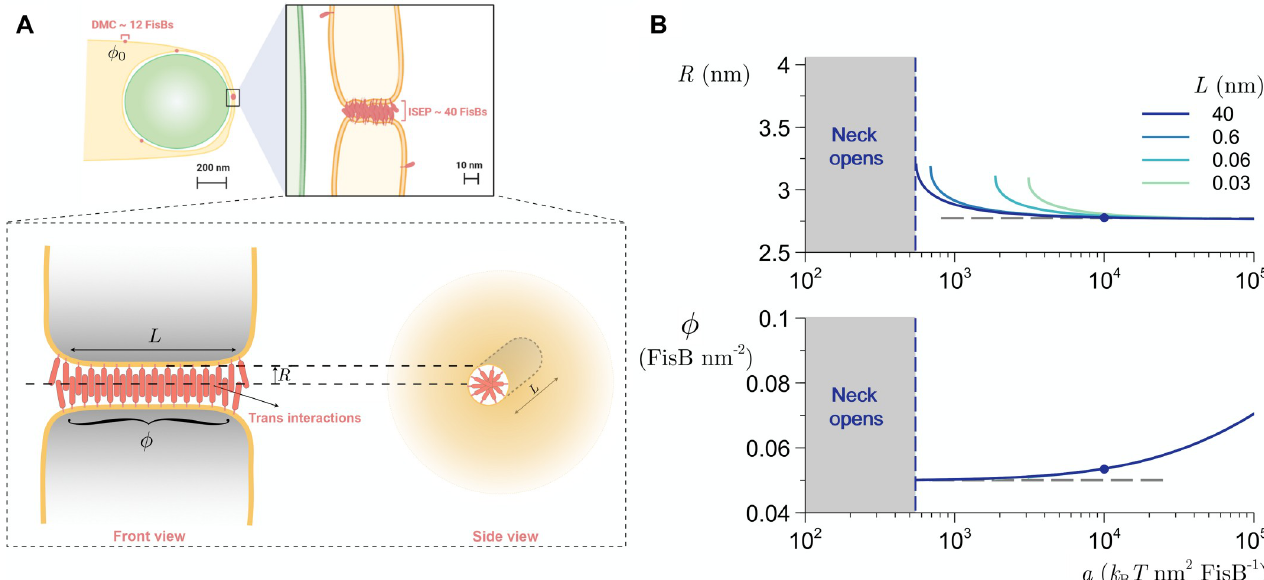
Fig 9. Modeling supports recruitment of FisB to membrane neck via oligomerization without curvature sensing. (A) Left: schematic of the late stages of engulfment, when a small membrane neck connects the engulfment membrane to the rest of the mother cell membrane. Right: schematic of FisB accumulation at the fission site. FisB freely moves around the engulfment membrane and other regions of the mother cell membrane, forming clusters of up to approximately 12 molecules. Cluster motions are independent of lipid microdomains, flotillins, the cell wall synthesis machinery, and voltage or pH gradients. About 40 copies of FisB accumulate at the membrane neck in an immobile cluster. Bottom: modeled axisymmetric membrane neck of radius R and length L connecting two membrane sheets. The uniform areal concentration of FisB in the neck is ϕ . (B) Top: equilibrium radius of the neck as a function of FisB trans homo- oligomerization strength, a , for several values of neck length, L . Below a minimum interaction strength, FisB cannot stabilize the neck and the neck opens. The horizontal line is the radius corresponding to the minimum of the potential describing the trans -interaction, R = 2 1/6 σ (Eq 3). Bottom: equilibrium FisB concentration in the neck as a function of a . The horizontal line is � ¼ 2 = ð 3 3 = 2 r 2 Þ , the concentration of FisB at the onset of in-plane crowding. Model r max max parameters (see Eqs 5 and 6): κ = 20 k B T (ref. 78), ϕ 0 = 100 FisB μ m − 2 , γ = 10 − 4 N m − 1 (ref. 79), σ ’ σ cis = 2.47nm, � ¼ 32 : 78 k ¼ 5 � 10 4 FisB T nm (cid:0) 2 ; � B r max μ m − 2 , L = 40 nm, and for the dot a = 10 4 k B T nm 2 FisB − 1 . For details, see S2 Appendix. DMC, dim mobile cluster; FisB, fission protein